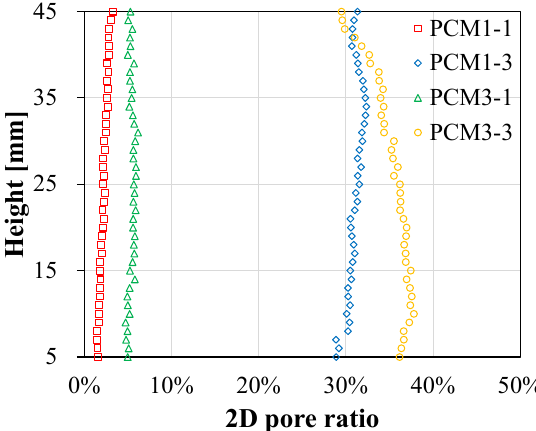
Figure 9. Distribution of the 2D pore ratios obtained through X-ray CT analysis along the height direction.